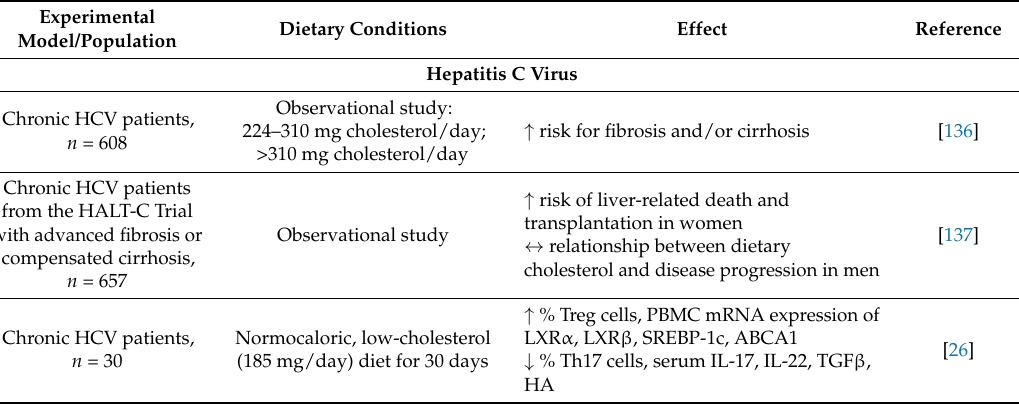
Table 2. Effects of dietary cholesterol on the pathophysiology of viral